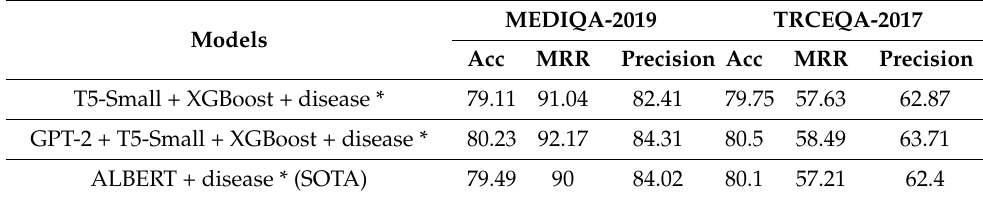
Table 5. Experimental results: comparison with